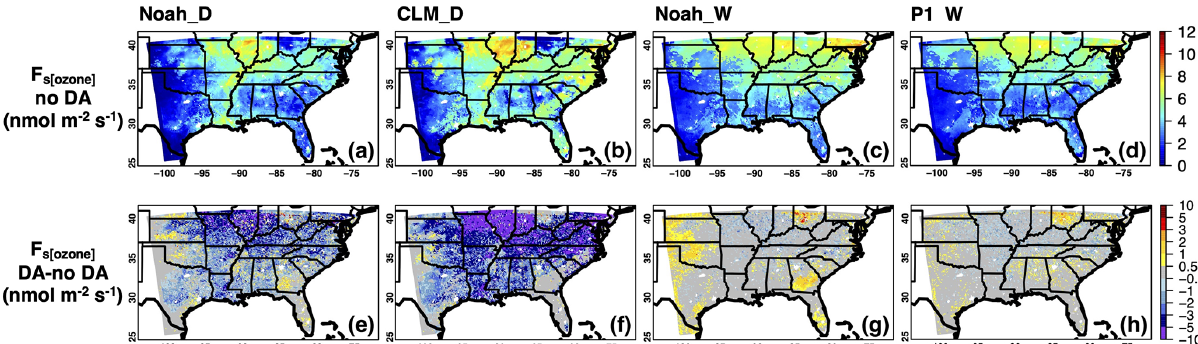
Figure 14. Period-mean (16–28 August 2016) WRF-Chem (a–d) daytime stomatal O 3 uptake F s [ ozone ] fields over terrestrial regions that do not belong to the urban category in Fig. 1a and (e–h) their responses to the SMAP DA. Results based on the (a, e) Noah_D, (b, f) CLM_D, (c, g) Noah_W, and (d, h) P1_W cases are